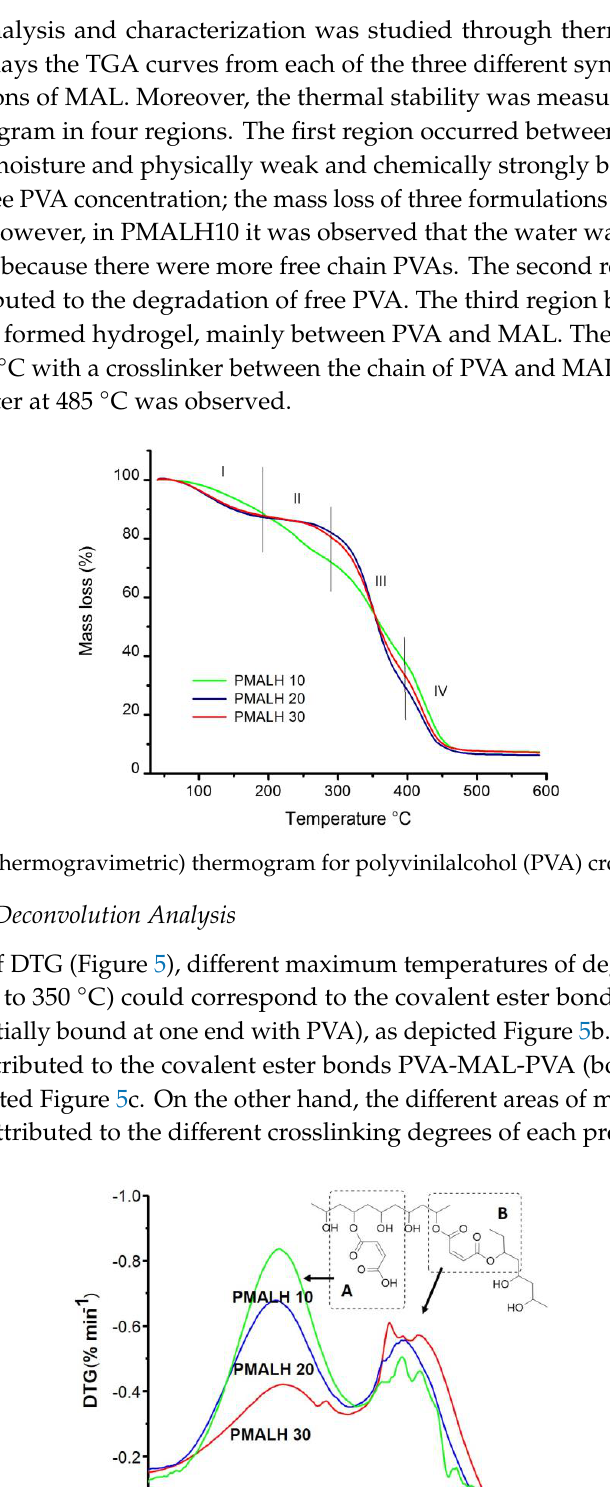
Figure 5. DTG between 280 and 500 °C and possible crosslinking. ( A ) fraction PVA-AM and ( B ) fraction PVA-AM-PVA.